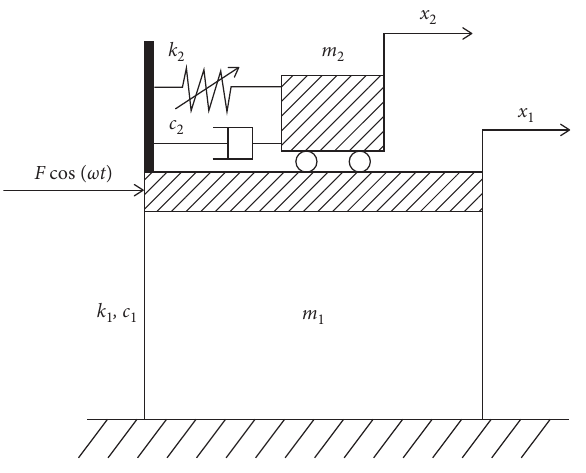
Figure 1: Simplified model of the 2-DOF